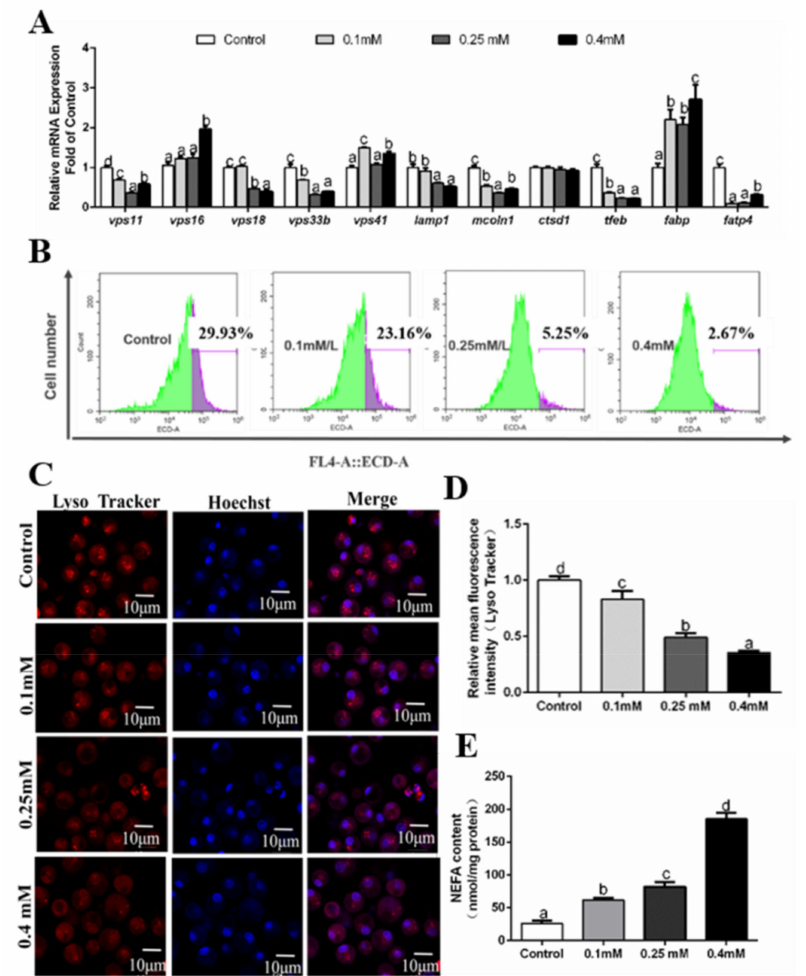
Figure 5. E ff ects of 48 h PA incubation on autophagosomes in hepatocytes of P. fulvidraco. ( A ) The e ff ect of 48 h PA incubation on the mRNA levels of autolysosome-related genes; data (mean ± SEM, n = 3) were expressed relative to expression of housekeeping genes ( b2m and gapdh (M = 0.1550)). ( B ) The e ff ect of 48 h PA incubation on intracelluar autolysosomes demonstrated by flow cytometry analysis of the presence of Lyso Tracker-stained intracellular autolysosomes. ( C ) Representative confocal microscopy image of hepatocytes co-stained with Hoechest (blue) and Lyso Tracker (red) after 48 h PA incubation. ( D ) The e ff ect of 48 h PA incubation on intracelluar autolysosomes demonstrated by flow cytometric analysis of red (FL4) mean fluorescence intensity. ( E ) E ff ects of 48 h PA incubation on NEFA content. Letters ( a–d ) denote significance, p <